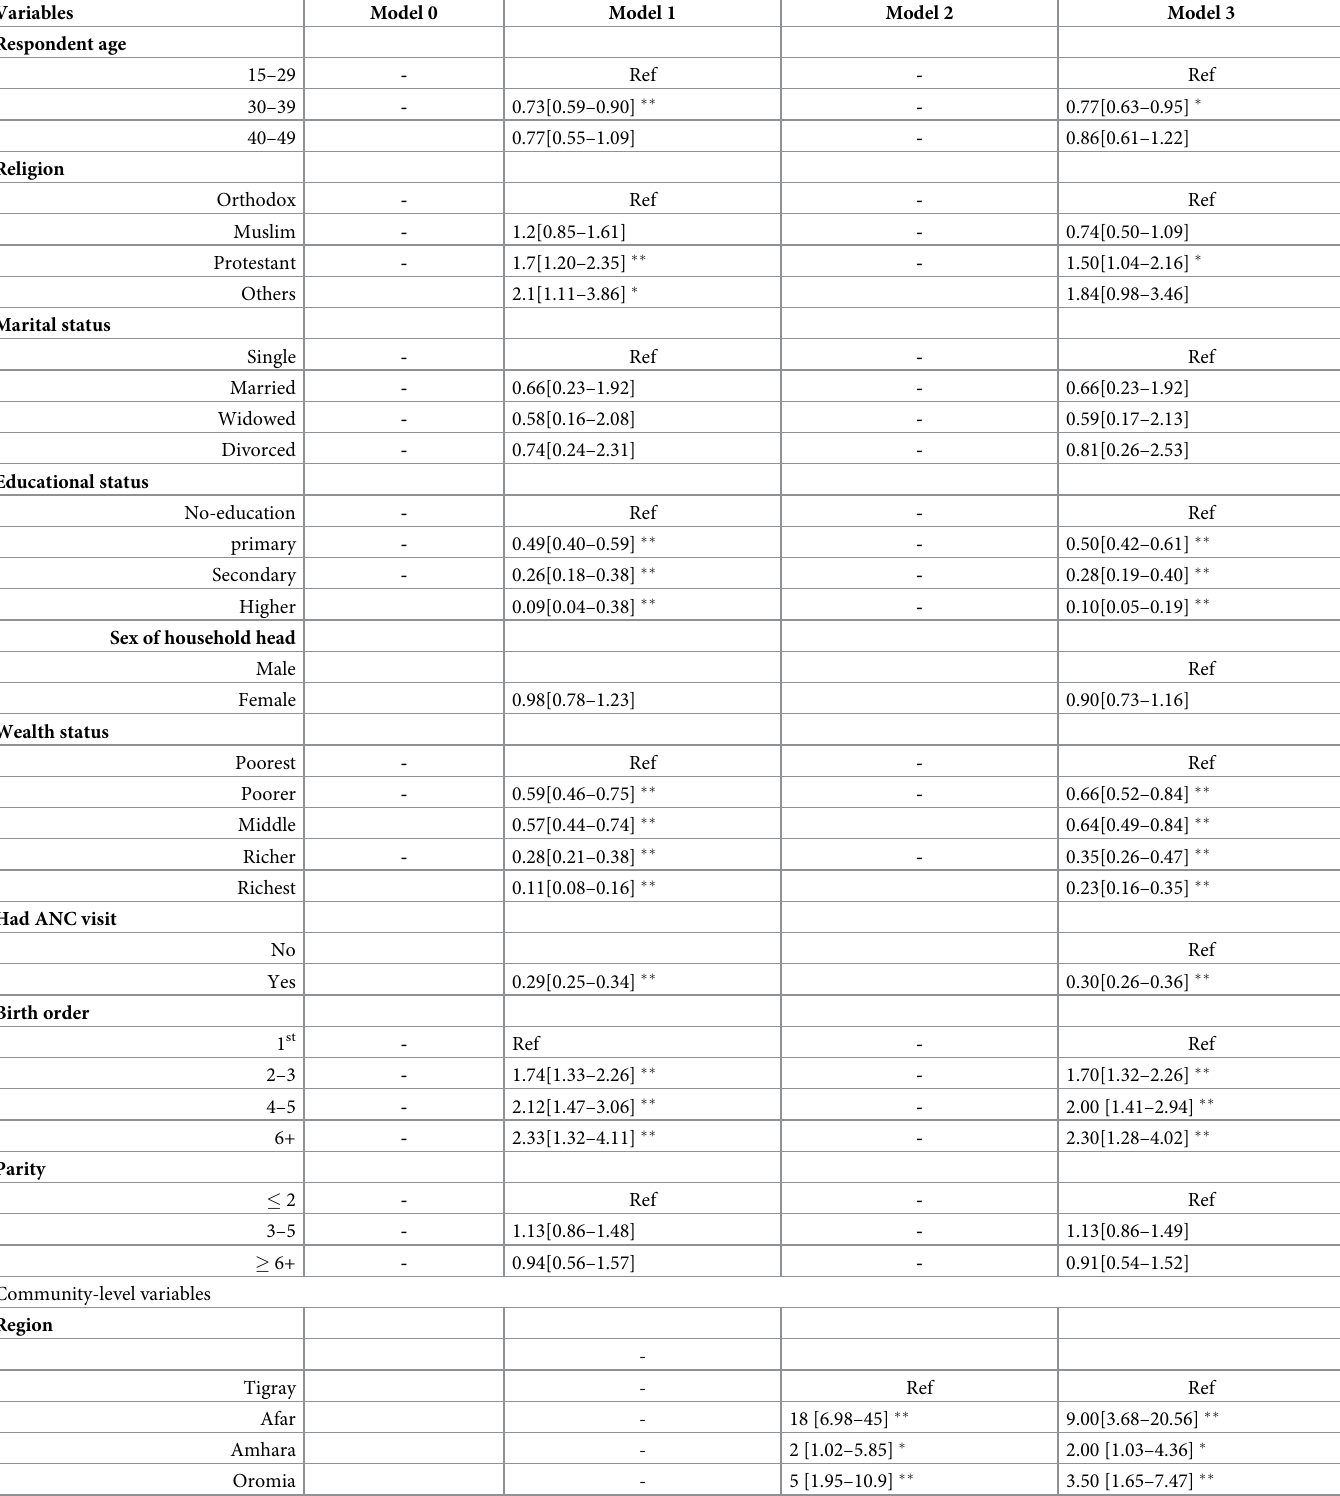
Table 3. Factors associated with home delivery in Ethiopia, EMDHS